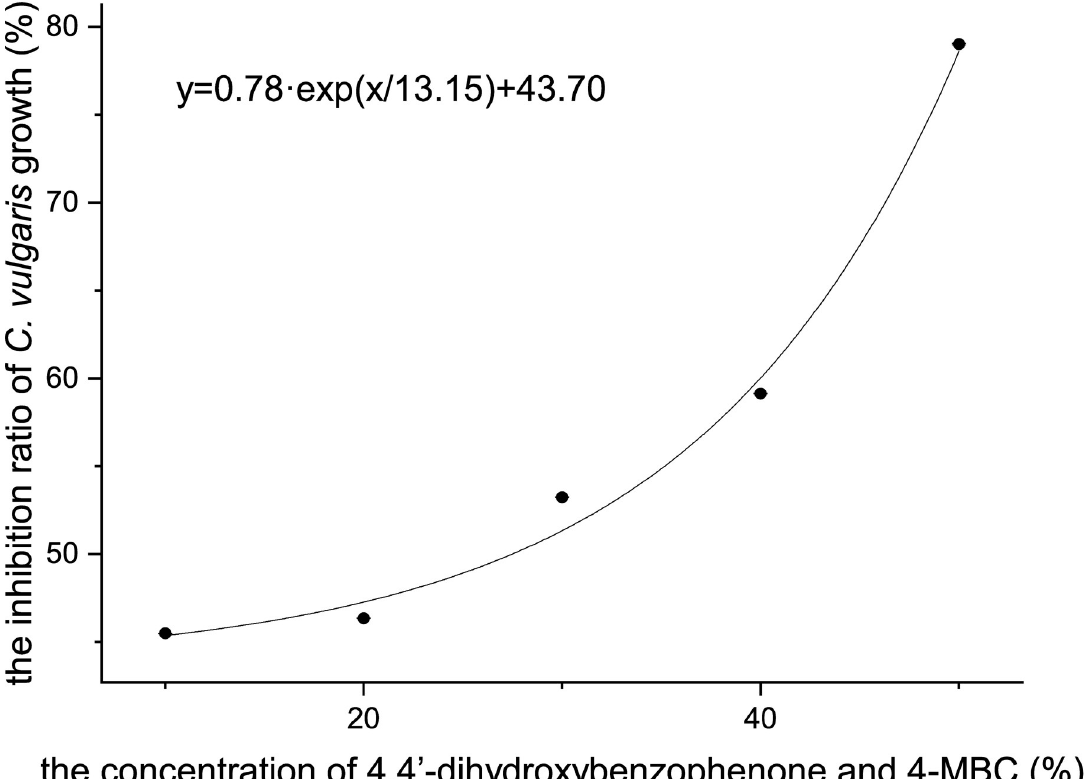
Fig 5. The inhibition ratio of C . vulgaris growth of a mixture of 4,4’-dihydroxybenzophenone and 4-MBC.